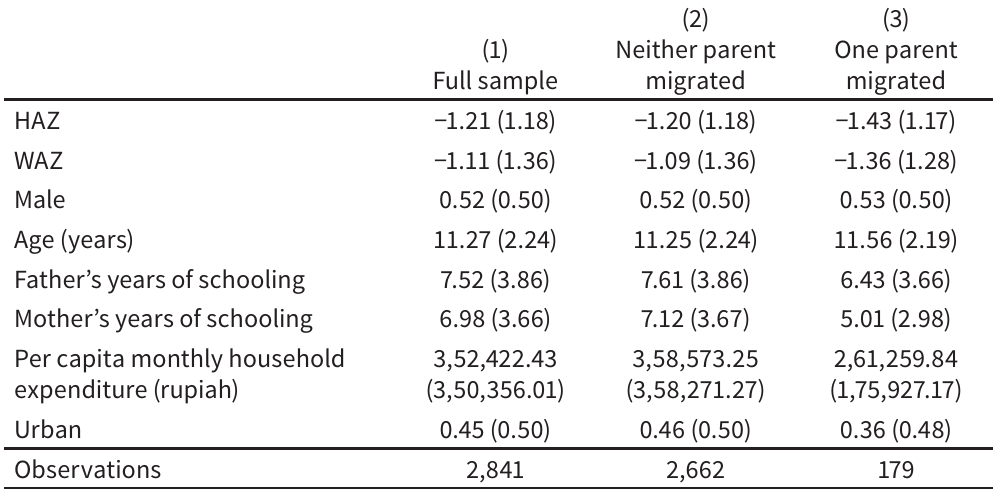
Characteristics of children by migration status of parents (year